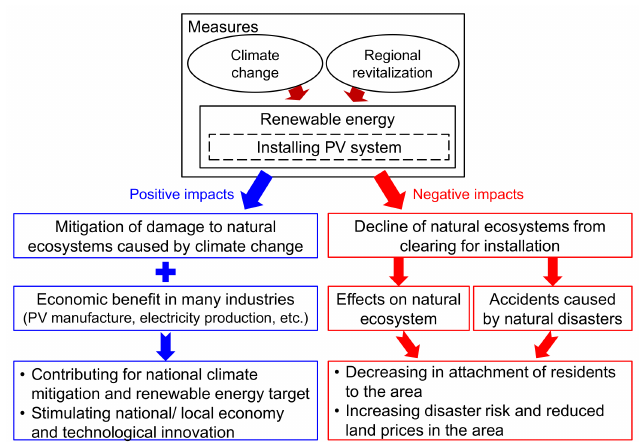
Figure 1. Relationship between a PV system and natural